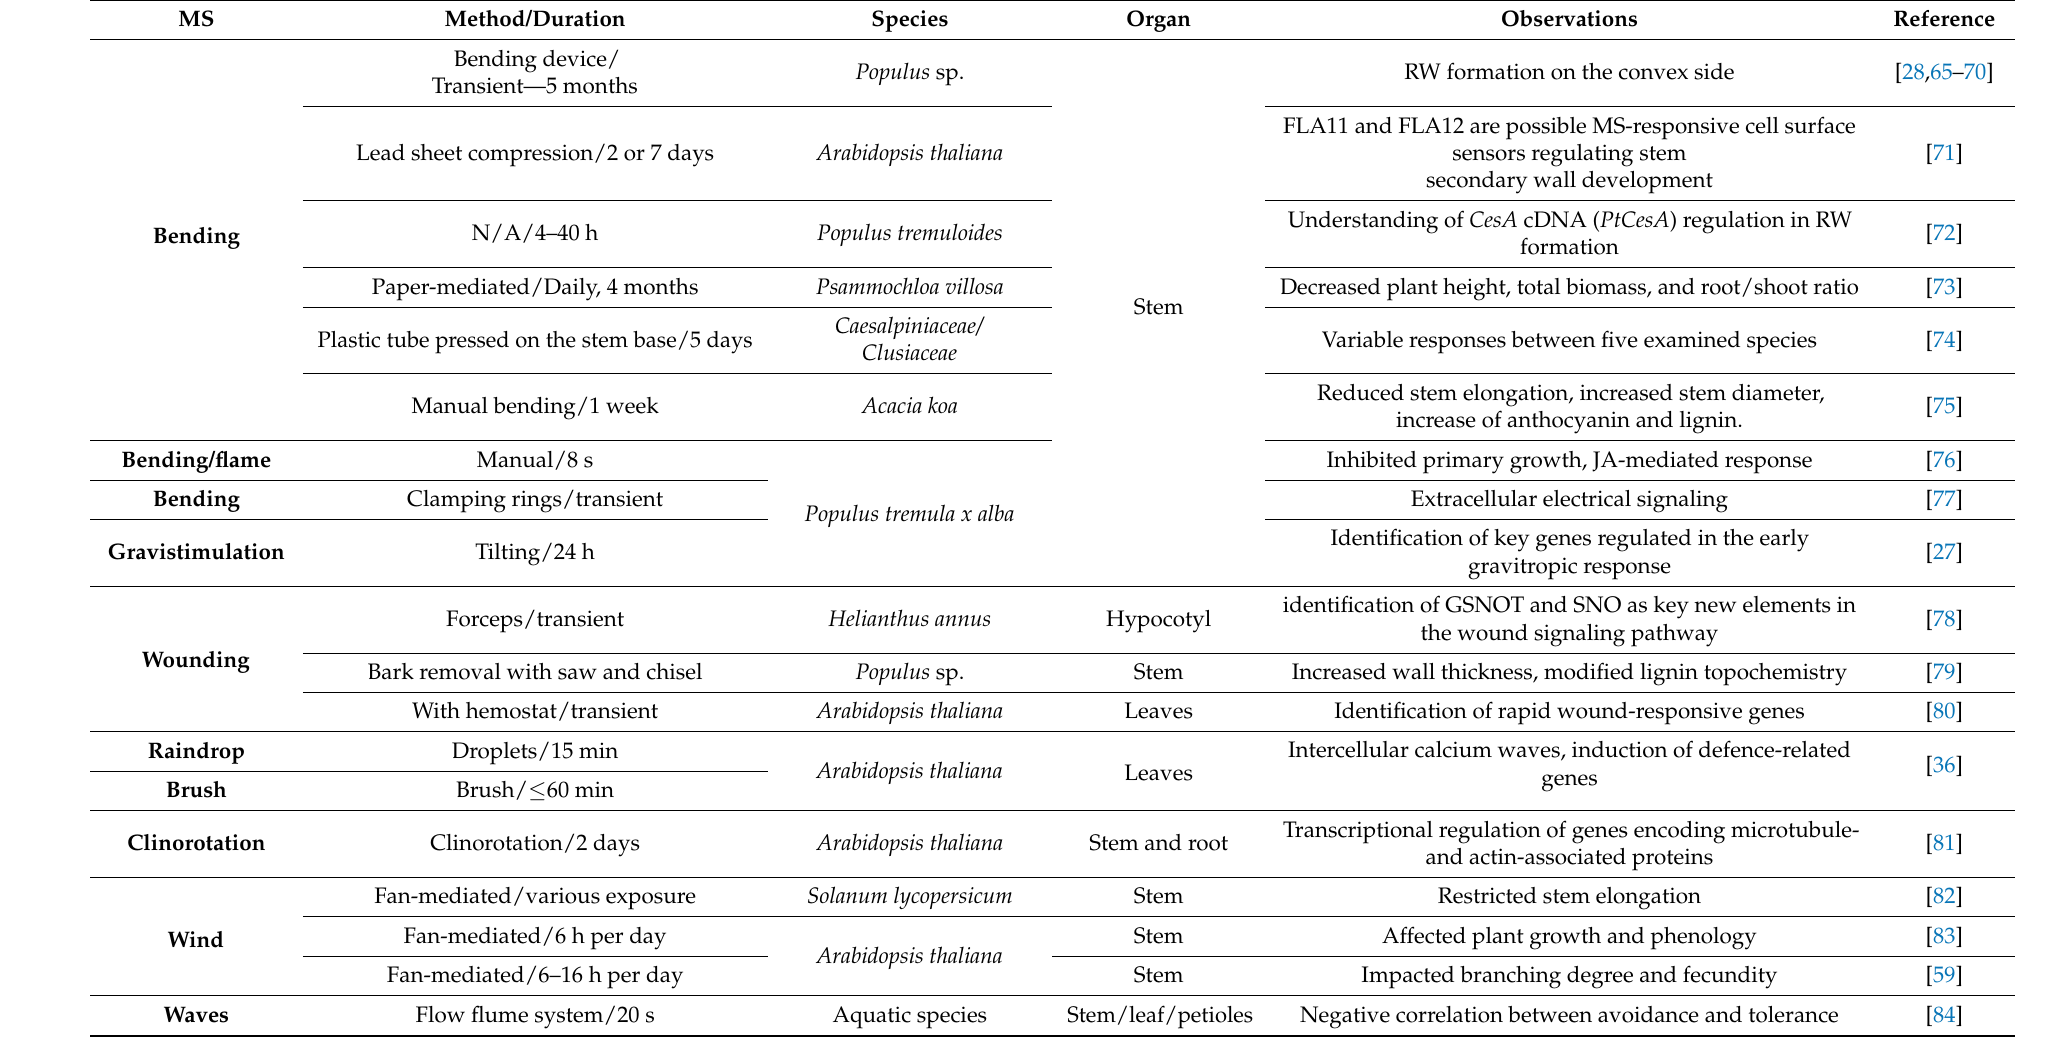
Table 1. Summary of experimental designs with the different methods of mechanical stress applications to various plants species and organs of